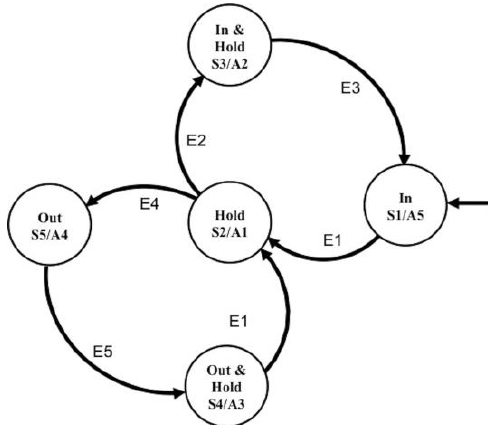
Figure 10. State transition map for the position control algorithm.